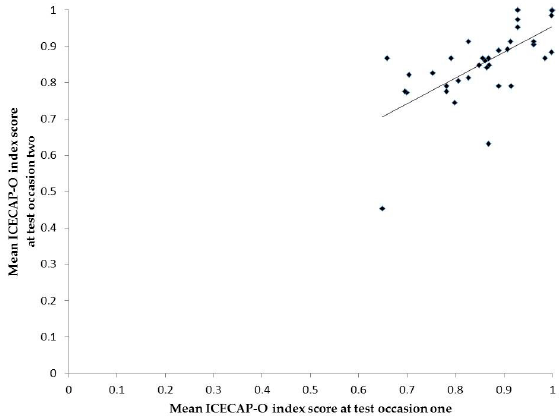
Figure 1. Correlation between ICECAP-O index scores at test occasion one (x-axis) and test occasion two (y-axis). Possible range from 1.00 (full capability), to 0.00 (no capability).